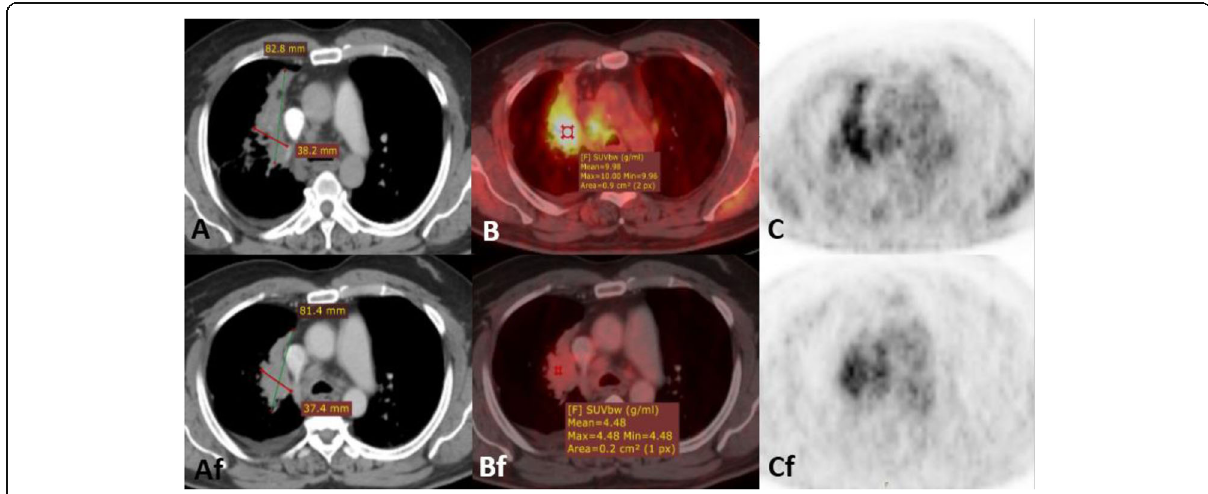
Fig. 11 A male patient 40 years old diagnosed to have NSCLC received radiotherapy and chemotherapy. Baseline study ( A , B , and C ) showed the mass lesion = 82 × 38 mm on average with SUV uptake = 9.9. On follow-up after 3 months ( Af , Bf , and Cf ) showed almost stationary course regarding the size of the mass by CT = 81 × 37 mm in average interpreted as stable disease by RECIST criteria while on PET/CT the SUV decreased to be 4.4 instead of 9.9 leading to change in the opinion to be partial response by PERCIST